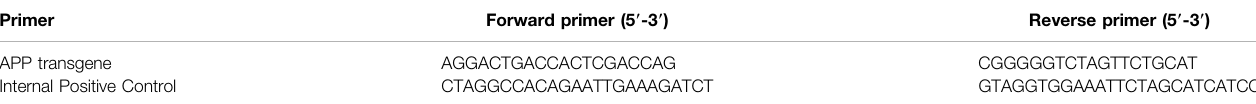
TABLE 1 | Primers used for mouse genotyping.